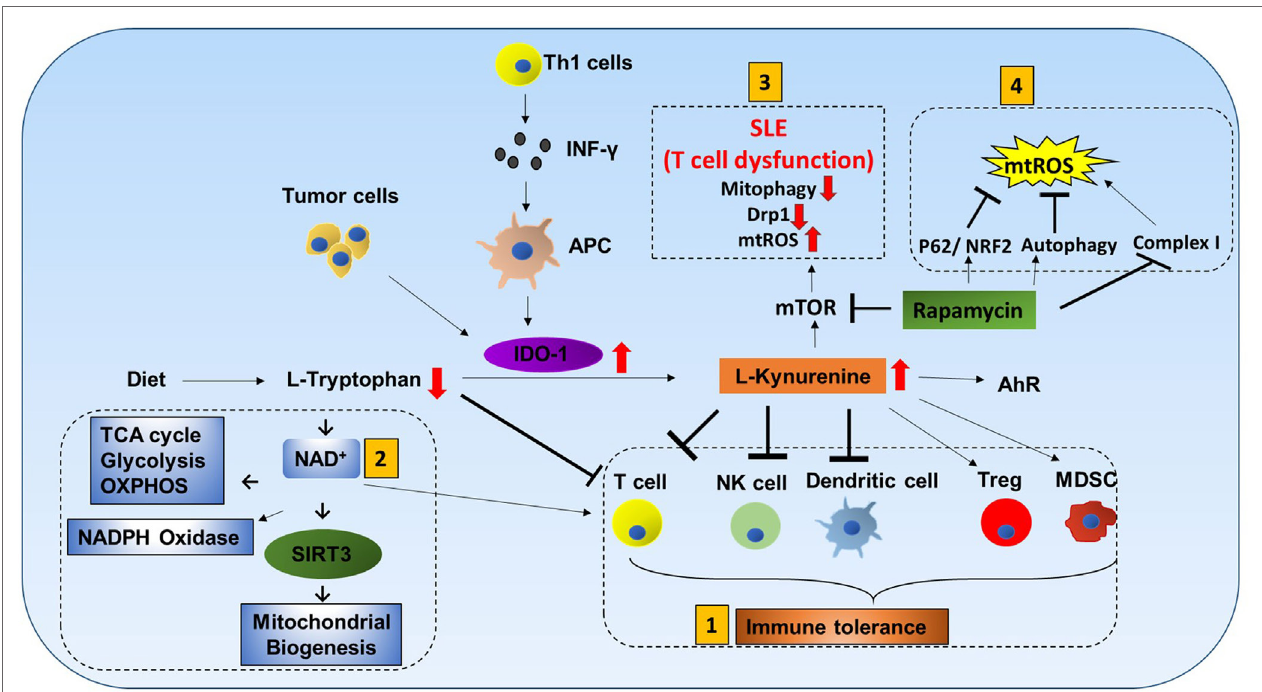
FiguRe 5 | Tryptophan metabolism mediated immune cell response. L-tryptophan (Trp) can only be obtained in the human body from dietary sources. It is catabolized by the enzyme indoleamine-2,3-dioxygenase-1 (IDO-1) to L-kynurenine (Kyn). Interferon- γ produced by Th1 cells stimulates IDO-1 production in